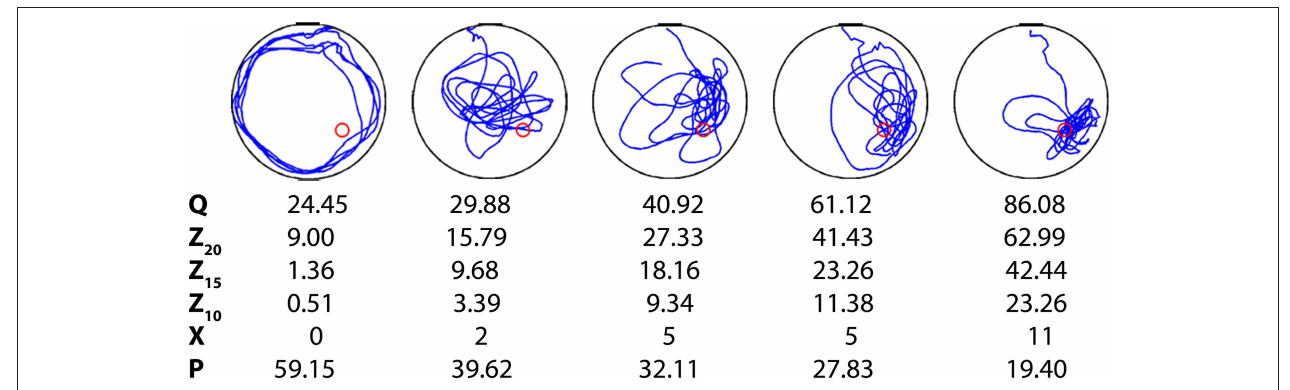
FIGURE 1 | Examples of fi ve individual probe tests. Mice were trained in the water maze with six trials per day for 5 days. Shown are representative swim paths in a probe test conducted following the completion of training.